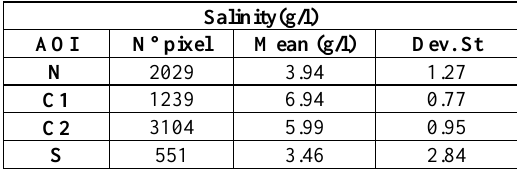
Table 9. Basic statistics of salinity values of the Classe AOIs